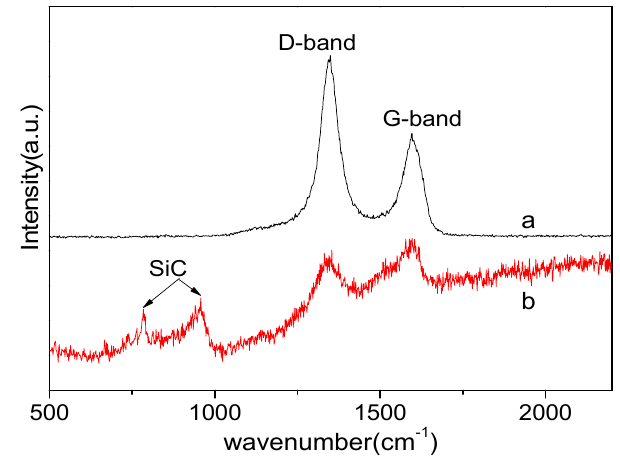
Figure 4. Raman spectra of the SiC–ZrC fibers obtained at 1600 °C via the Ar–Ar process ( a ) and the H 2 –Ar process ( b ).